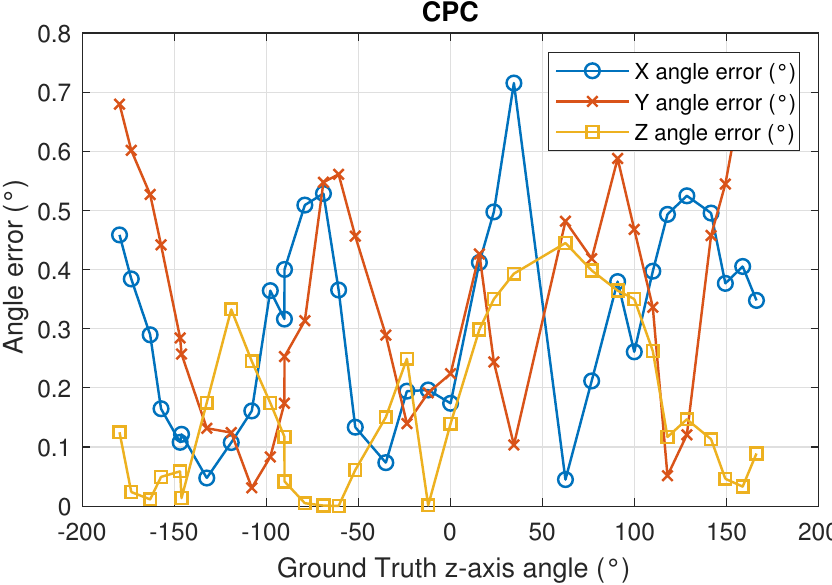
Figure 17. Angle error in the 3 axes using CPC in function of the true value rotation angle (z